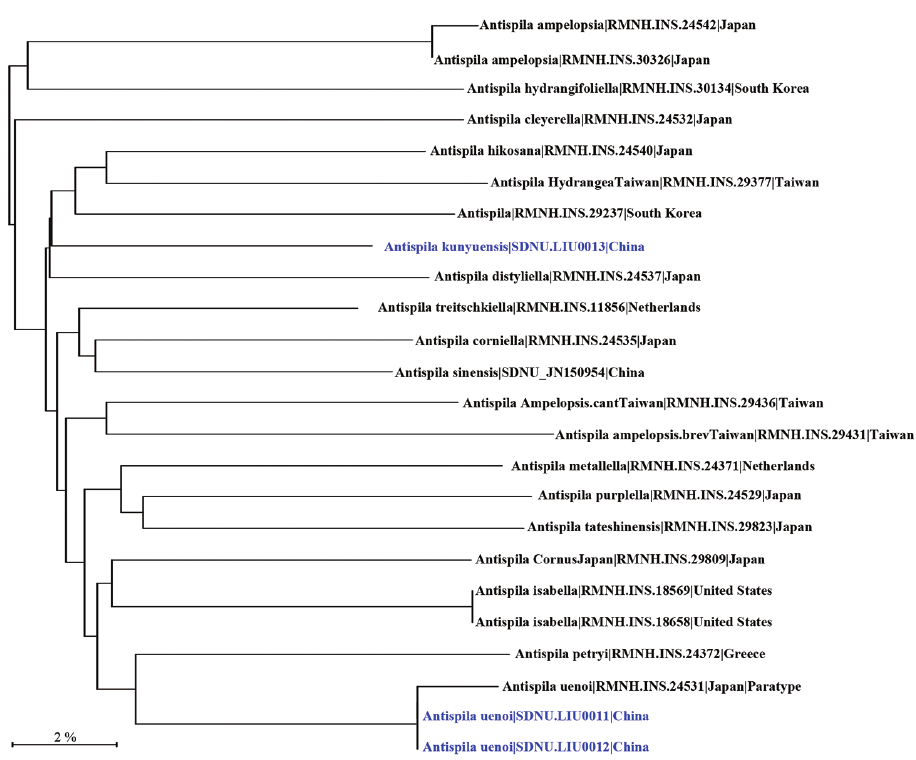
Figure 33. Neighbor Joining Tree, based on DNA barcodes of Antispila species, especially Vitaceae- feeding and Asian